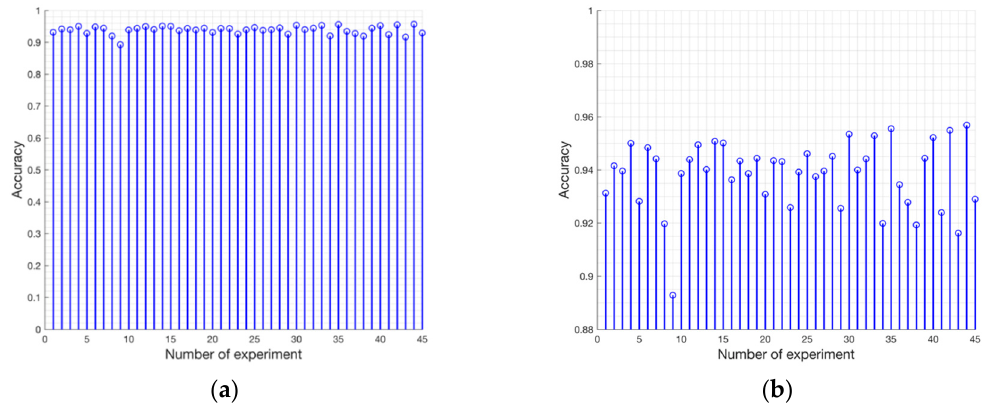
Figure 10. Accuracy values obtained with distinct training and validation set pairs. ( a ) and ( b ) graphs represent the same data. In ( b ) graph the y-axis limits are different only for better visualization.